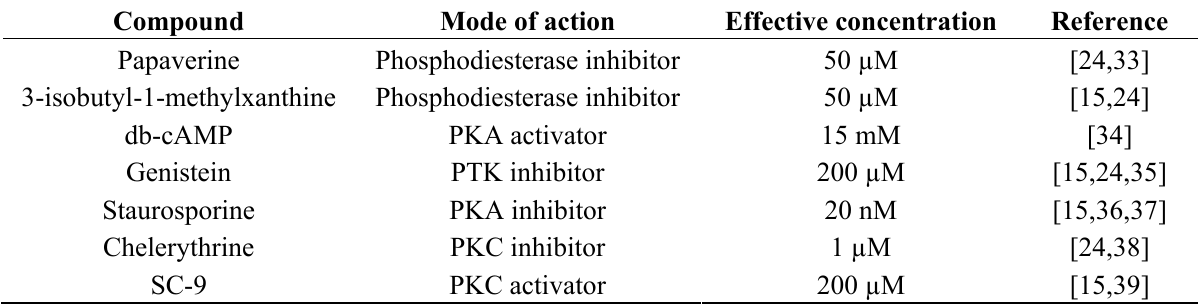
Table 1. Pharmacological compounds that affect light control of